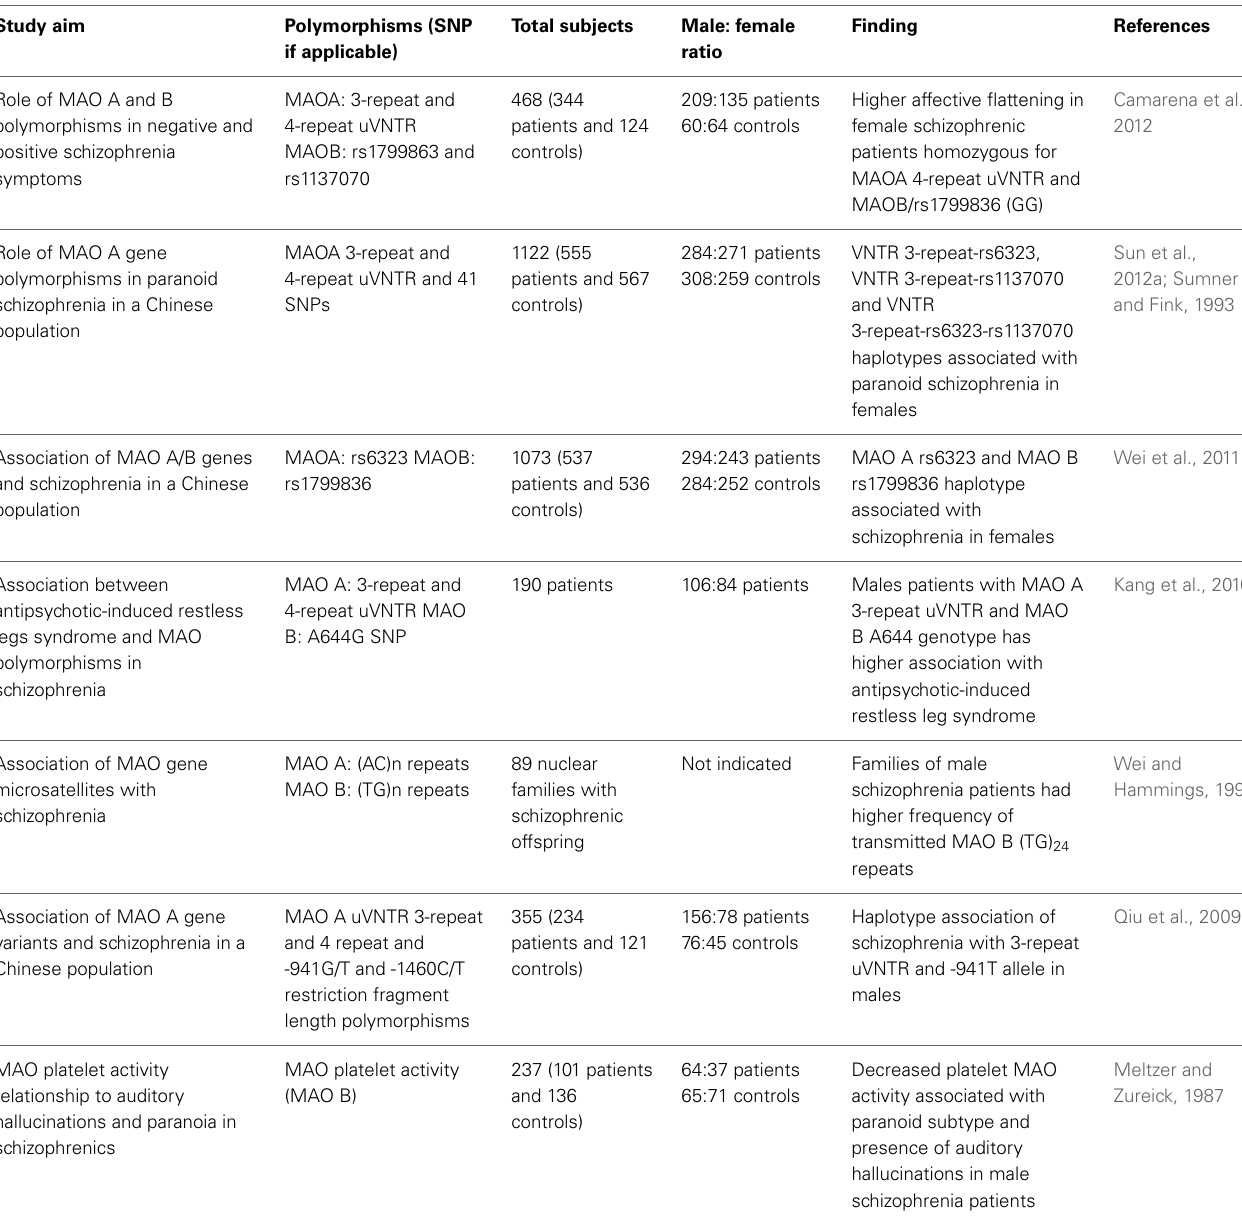
Table 2 | List of major studies implicating the interaction between MAO polymorphic variants and sex in schizophrenia and related